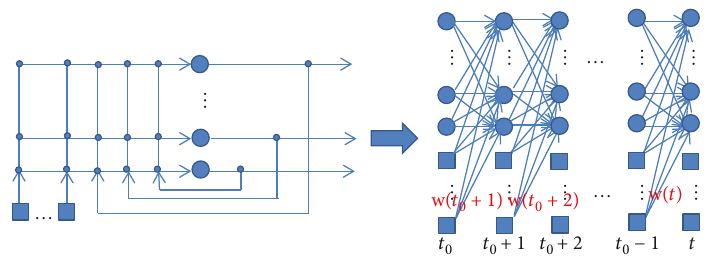
Figure 3: Recurrent neural networks are expanded into feedforward neural